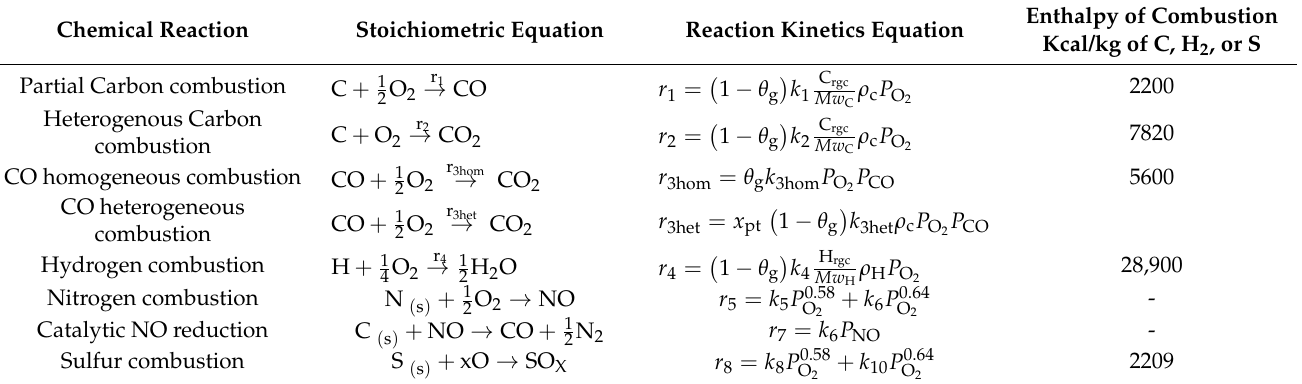
Table 1. Important coke combustion reactions occurring and heat of combustion in the FCC